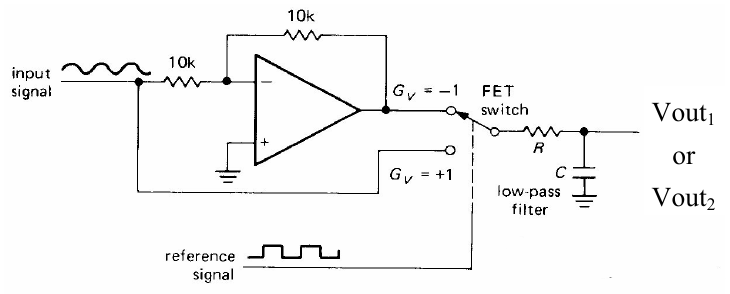
Figure 14. Principle of the synchronous detection module